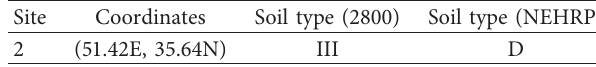
Table 1: Coordinates and soil type of the selected site.